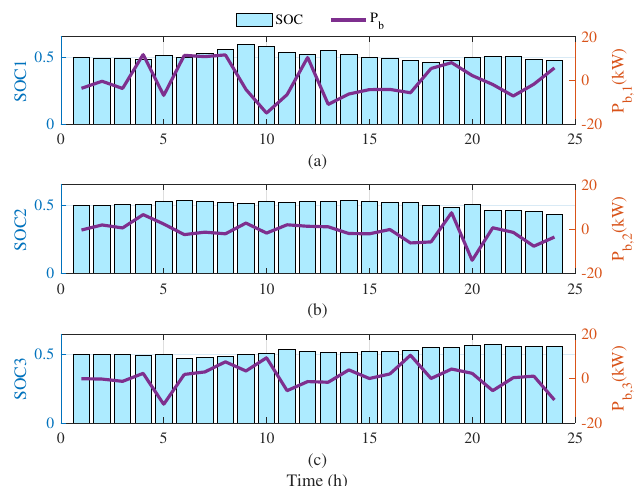
Figure 5. ESS daily profile. ( a ) MG 1 ( b ) MG 2 ( c ) MG 3.